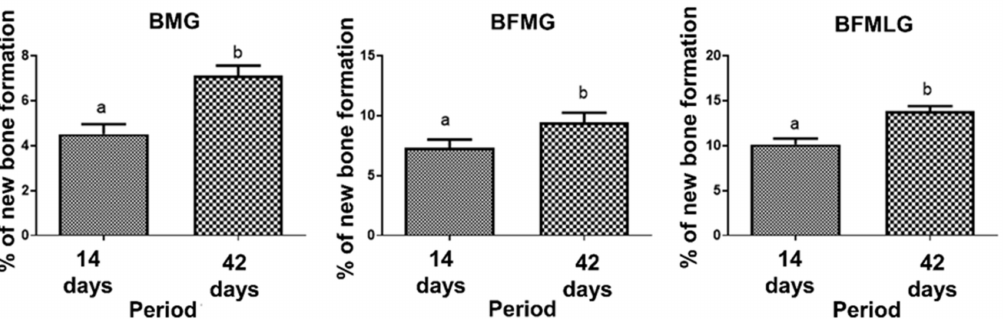
Figure 4. Percentage of new bone formation in each group (BMG, BFMG, and BFMLG) in the two experimental periods (14 and 42 days). Different lowercase letters indicate significant difference. Values defined as the mean ± standard deviation ( p < 0.05), unpaired t -test.